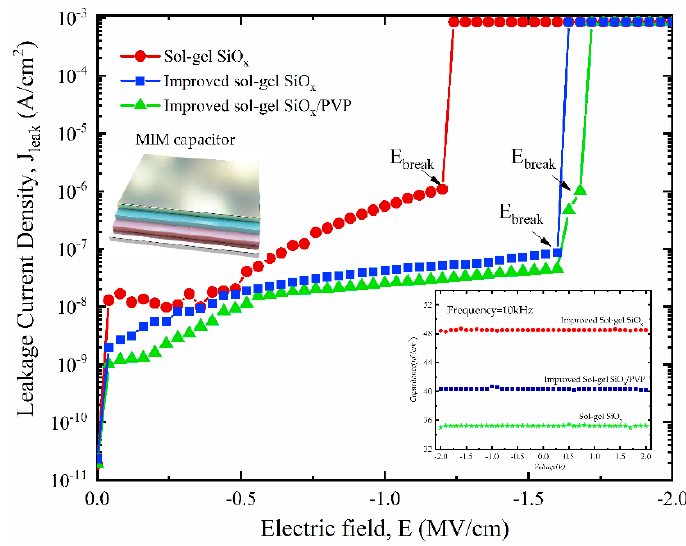
Figure 3. Field-dependent leakage current density for sol–gel SiO x (~150 nm), improved sol–gel SiO x (~150 nm), improved sol–gel SiO x /PVP (~150 + 20 nm). Inset: capacitance of the related MIM capacitor.